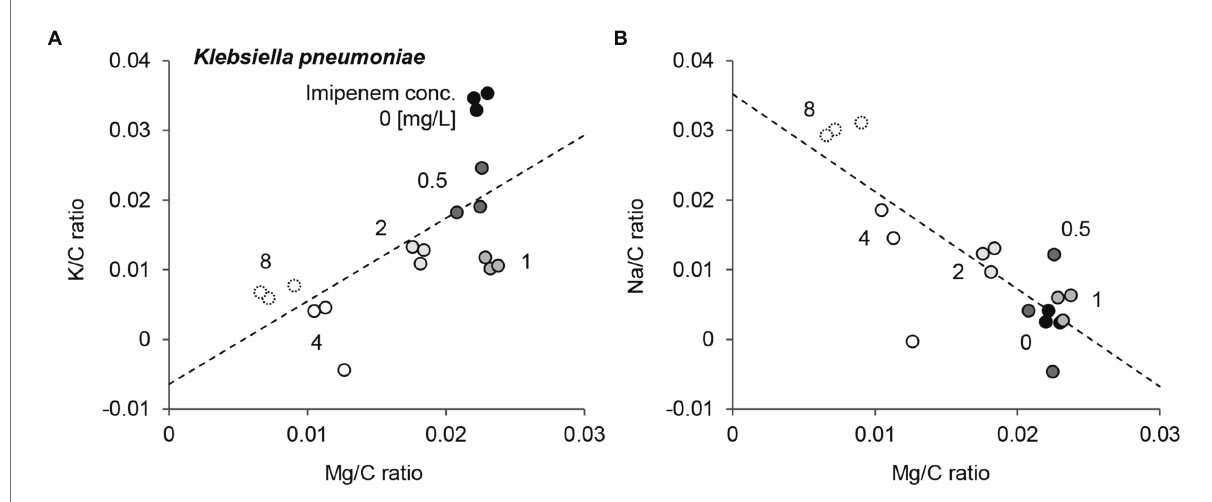
FIGURE 4 Comparison of Mg/C ratio, K/C ratio, and Na/C ratio of a Klebsiella pneumoniae susceptible strain incubated with various concentrations of imipenem. K/C ratio (A) and Na/C ratio (B) as a function of Mg/C ratio. Numbers in the figure represent the imipenem concentration. Dashed lines are linear fitting for all